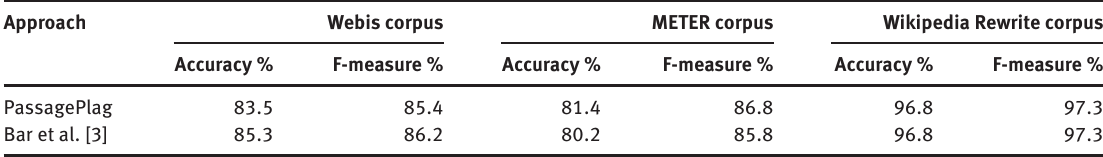
Table 3: Performance Comparison on Various Corpora.